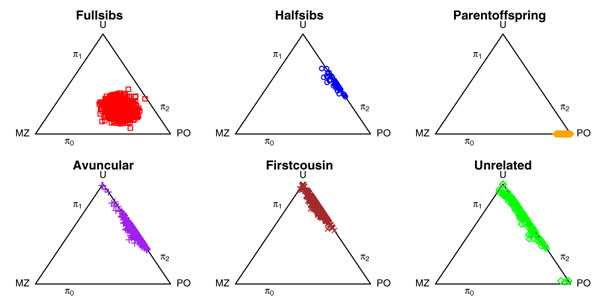
Scatter diagrams of estimated IBDs on the relationship triangles for six relationship categories Scatter diagrams of the IBD probabilities estimated by PREST on a relationship triangle reveal the extent of pedigree errors within a given relationship category. By far, the largest number of errors involves "unrelated" pairs that in fact appear to be related.